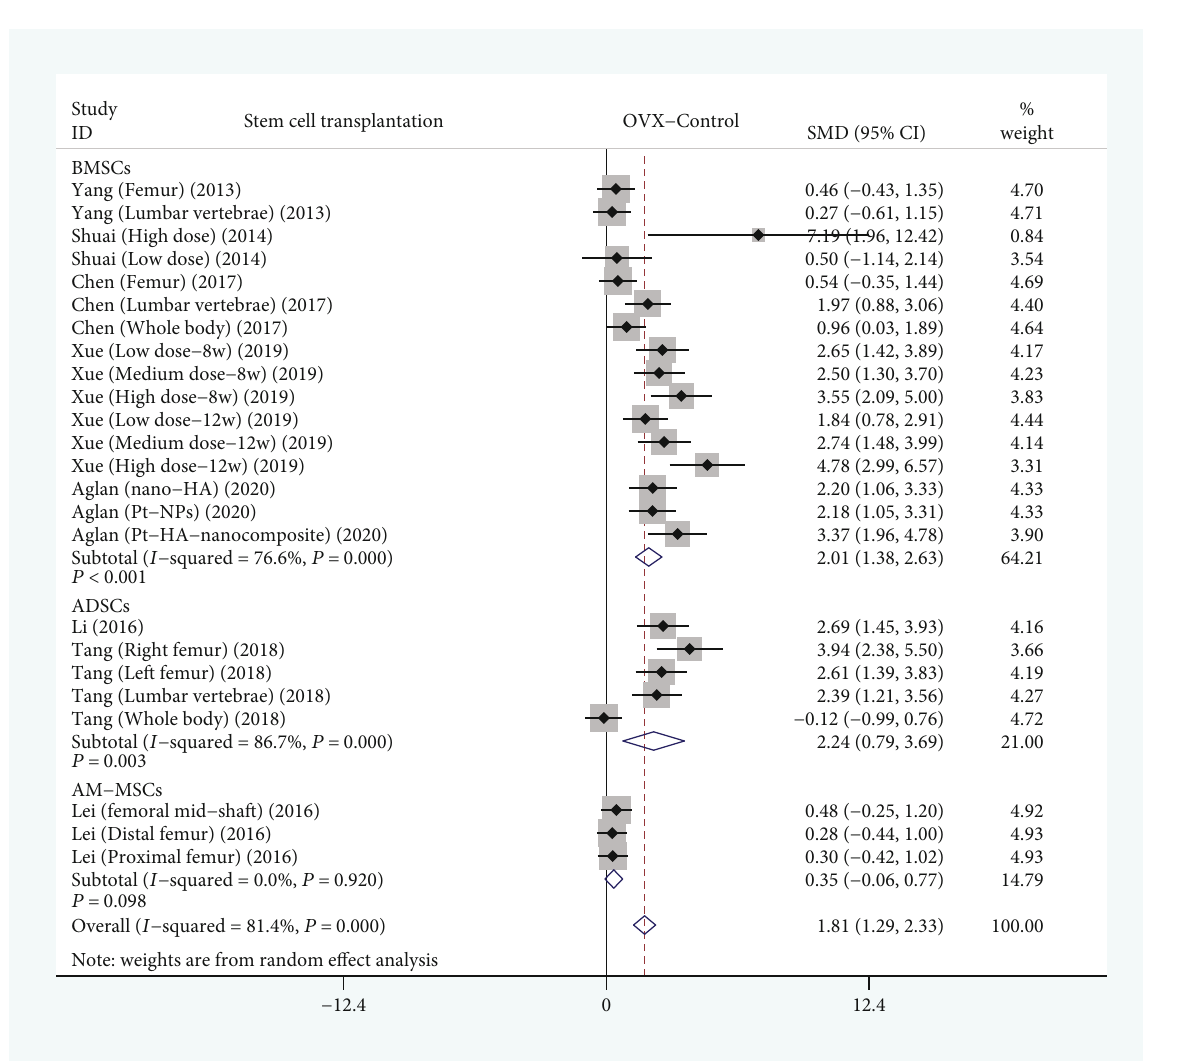
Figure 3: Forest plot showing the e ff ect of stem cell treatment group compared with OVX control group on BMD. OVX: ovariectomized; BMD: bone mineral density; BMSCs: bone marrow mesenchymal stem cells; ADSCs: adipose-derived stem cells; AM-MSCs: amniotic membrane mesenchymal stem cells; SMD: standard mean di ff